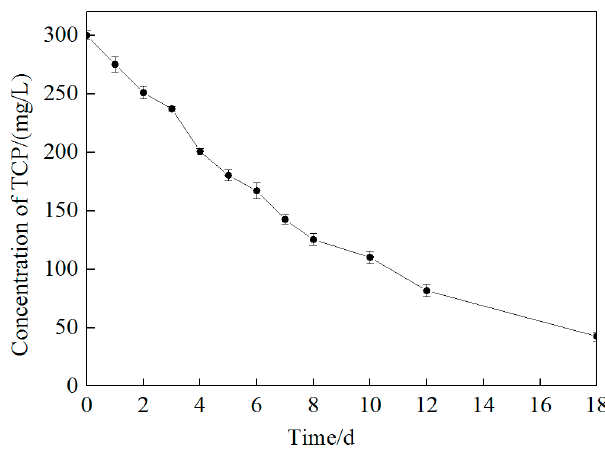
Figure4. ChangeofTCPconcentrationindeionizedwaterexperimentconductedwith20gsoil, 300mg / L Figure 4. Change of TCP concentration in deionized water experiment conducted with 20 g soil, 300 TCP, 9.69 g / L persulfate, and 20:5:1 molar ratio of S 2 O 82 − , Fe 2 + , and citric acid at ambient temperature. mg/L TCP, 9.69 g/L persulfate, and 20:5:1 molar ratio of S 2 O 82 − , Fe 2+ , and citric acid at ambient temperature.